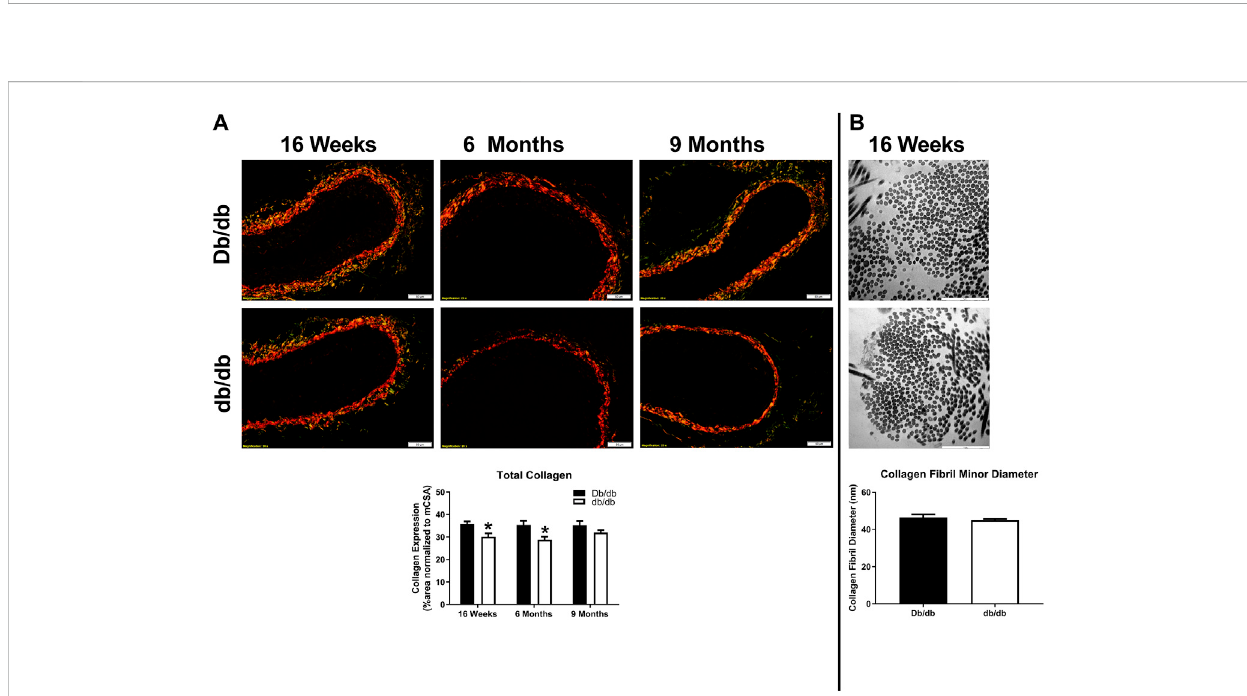
FIGURE 4 (A) Picrosirius red staining of normal and diabetic aortas revealed no overt differences in collagen expression as a function of age (16 weeks – 9 months ofage).However, collagen expression was signi fi cantly lower indiabetic db/db aortas at16 weeks and 6 months of age. Scale bars: 50 µm. Representative images from n = 4 per group. (B) Transmission electron microscopy (TEM) images did not reveal differences in collagen fi ber diameter between normal and diabetic aortas. Scale bars: 50 µm. Representative images from n = 4 per